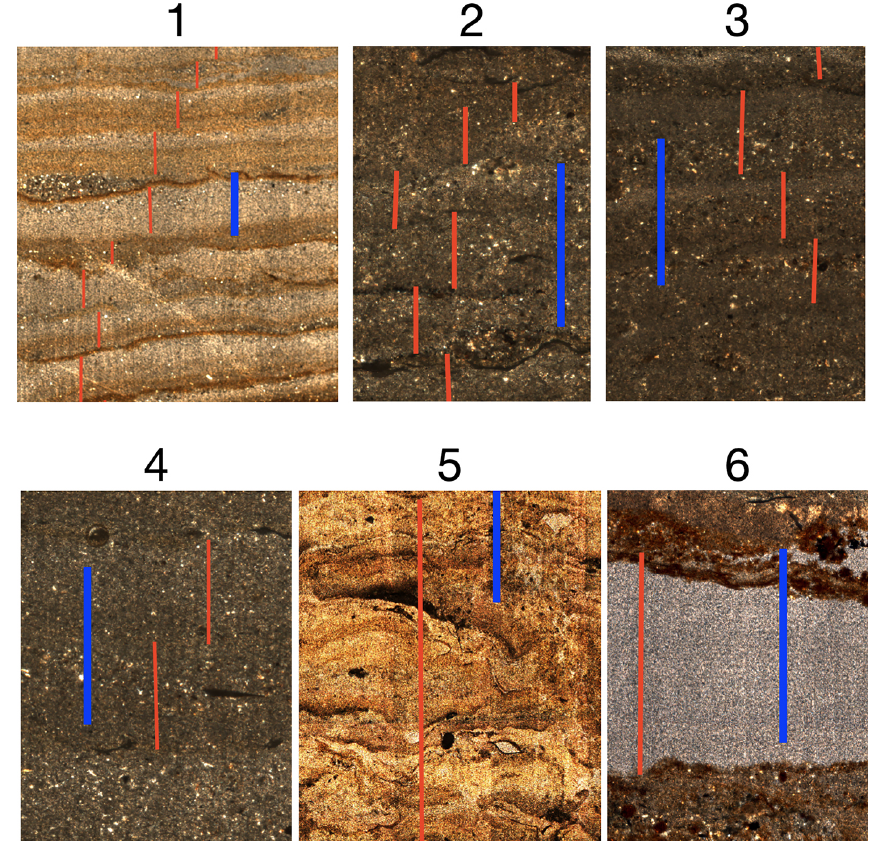
Figure A2. Examples of appearance for each lamination quality code for Columbine Lake sediment. The blue bar is 1mm in all images.